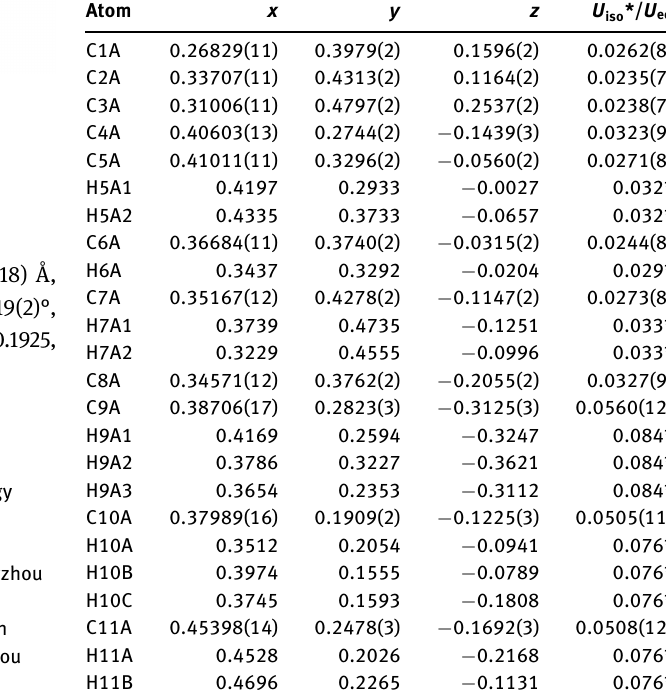
Table 2: Fractional atomic coordinates and isotropic or equivalent isotropic displacement parameters (Å 2